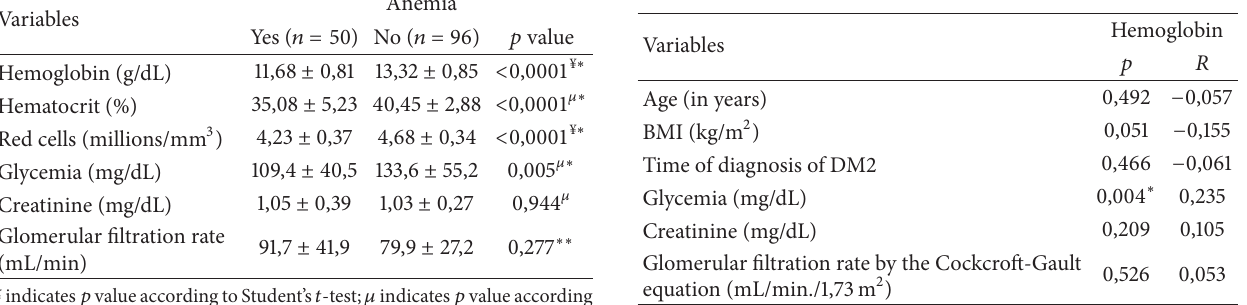
Table 3: Coefficients of correlation between clinical and biochem- ical parameters with the hemoglobin in patients with diabetes mellitus type